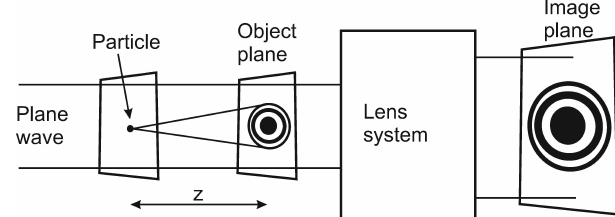
Fig. 1. Working principle of HOLIMO II: a plane reference wave il- luminates a particle. The reference wave and the scattered wave in- terfere and form a interference pattern (e.g., the hologram) at a dis- tance z . The lens system magnifies the hologram from the object plane to the image plane where the camera is